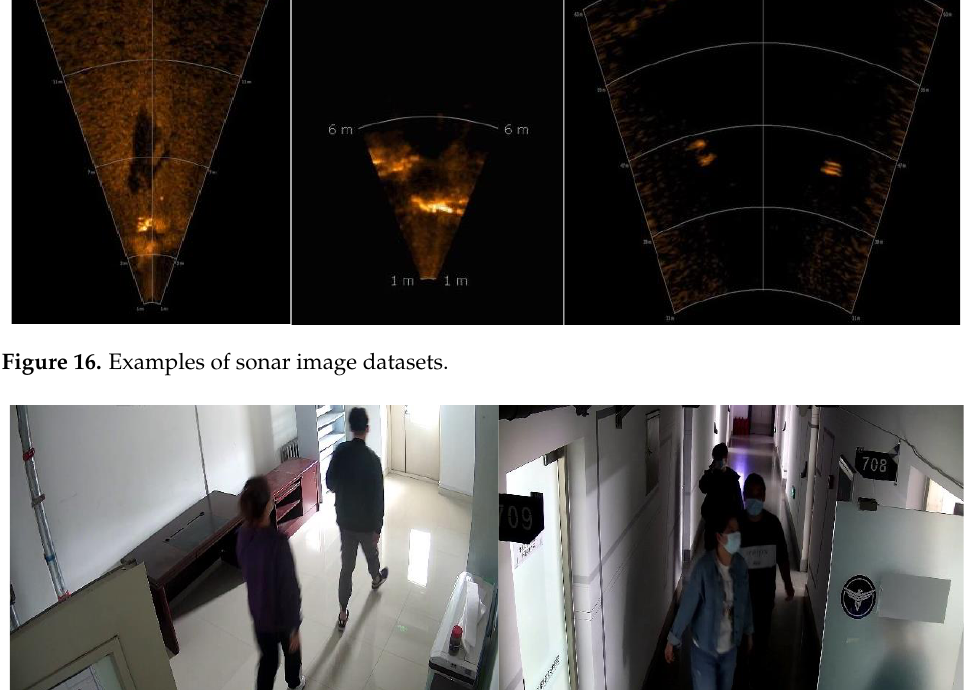
Figure 17. Examples of source domain datasets.